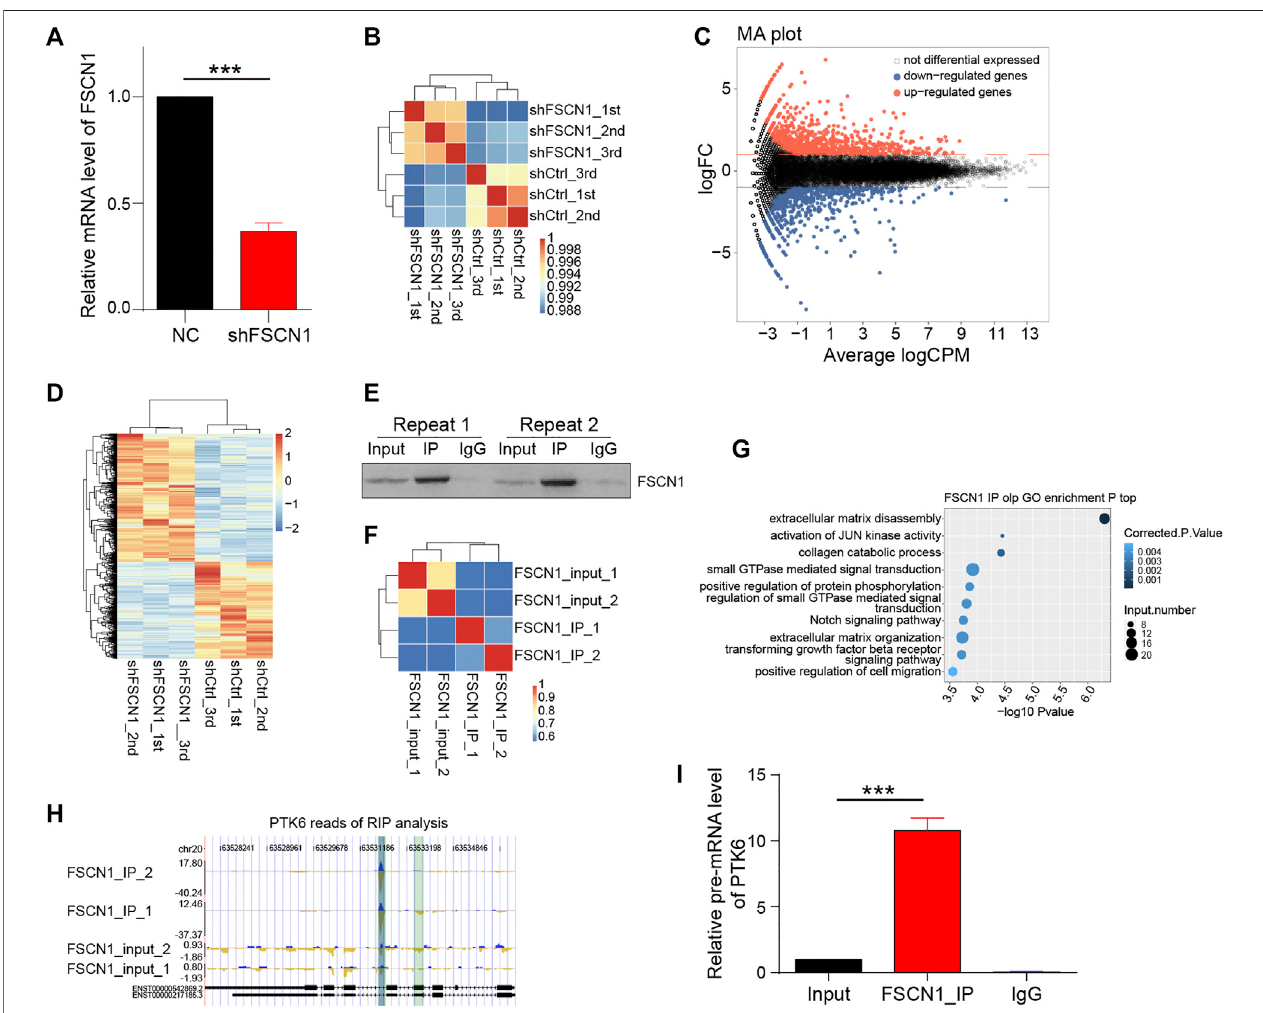
FIGURE 1 | Whole-genome expression sequencing and RIP assay. (A) Two ECA-109 groups were transfected with negative control (NC) and shFSCN1 separately. Relative mRNA level of FSCN1 was detected. n = 3 per group, *** p < 0.001. (B) ECA-109 cells were transfected with NC (shCtrl) and shFSCN1 separately. The sample correlation among the control groups (shCtrl) and FSCN1 knock down groups (shFSCN1) is shown. (C, D) The differentially expressed genes (DEG) were analyzed and shown. (E) RNA immunoprecipitation (RIP) was performed by using FSCN1 monoclonal-antibody in ECA-109 cell lysate. The immunoprecipitation was detected by western blotting. (F) The sample correlation is shown. (G) Gene Ontology enrichment is shown in the sequencing analysis of RIP in (F) . (H) The peak reads of the sequence of PTK6 pulled down by FSCN1 in RIP analysis. (I) ECA-109 lysates were immunoprecipitated by FSCN1 antibody or IgG. Relative pre-mRNA level of PTK6 was detected. n = 3 per group, *** p <